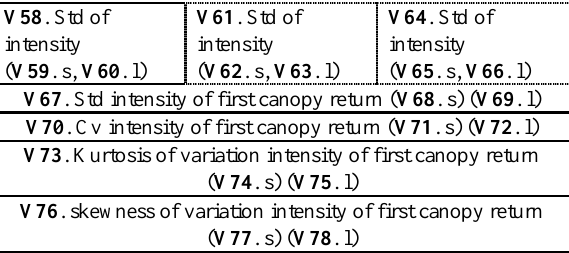
Table 2. Summary of features derived from vertical point profile: s= single; l= last; Std= standard deviation; Cv = coefficient of variation